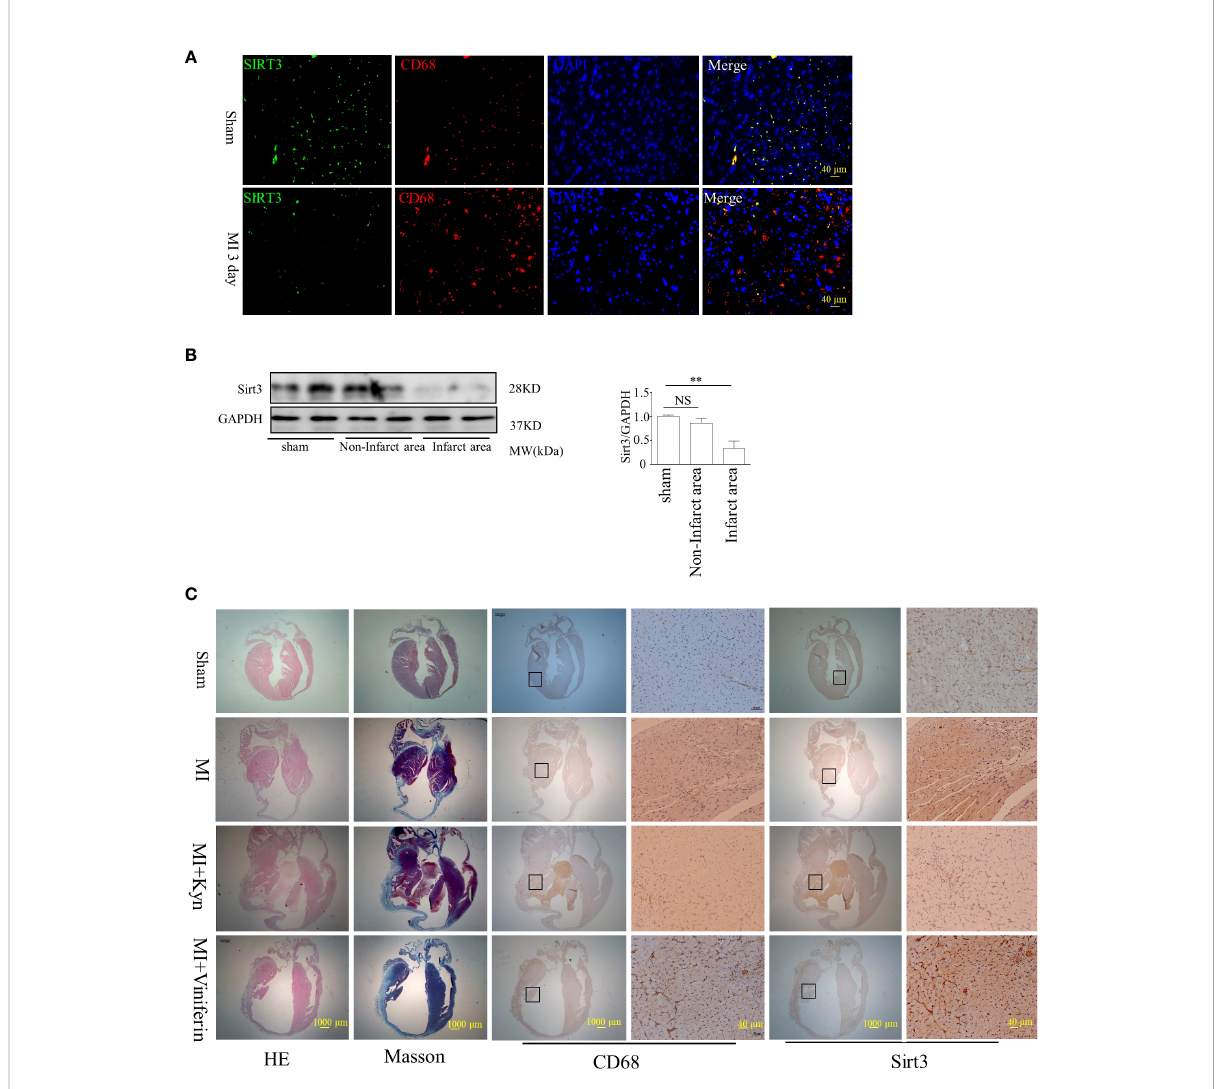
FIGURE 5 Kyn enhanced MI lesion size, and reversely Sirt3 activation alleviated the in fl ammatory response in the lesion area of MI. (A) Immunohistochemical analyses showed that Sirt3 and CD68 co-localized in the infarct area after MI, indicating that Sirt3 decreased in macrophages especially during the 1 − 3 days after MI, scale bar, 40 m m. (B) Sirt3 expression levels were analyzed in both infarct and non-infarct area after MI, n=3. NS, not signi fi cant, **P<0.01 vs sham. (C) Representative images showed H&E and Masson staining of myocardial tissue sections from control (sham) and MI mice subjected to Kyn (15 m mol) treatment. Kyn supplementation deteriorated the cardiac function in MI mice in vivo , and the in fi ltration of CD68 + macrophages in the region of MI was aggravated. Treating mice with the Sirt3 activator can signi fi cantly reduce the area of MI and improve the cardiac function after MI; in addition, the in fi ltration of macrophages at the site of MI was reduced, indicating that the Sirt3 activator (Viniferin) can decrease the in fl ammatory response in the area of MI, scale bar, 10 m m, scale bars 40 m